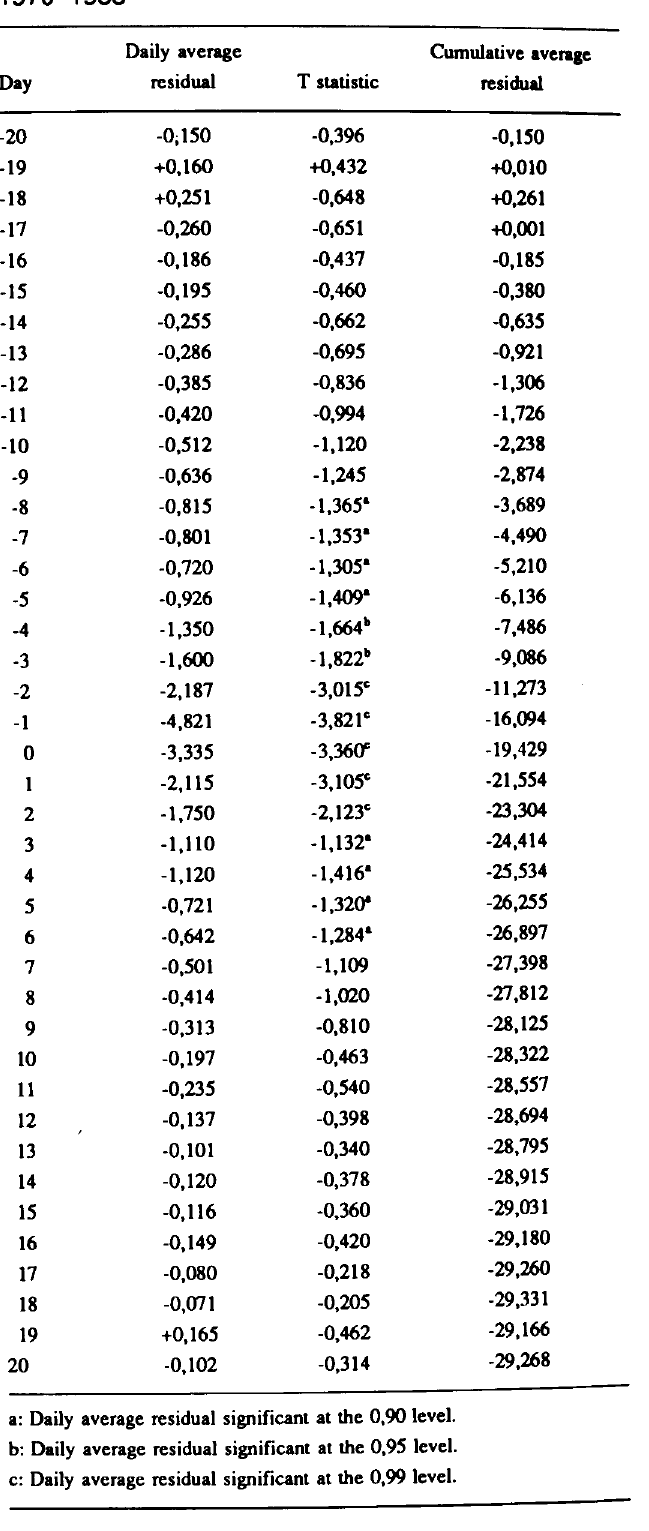
Table 1 Investment return residuals for large dividend decrease sample (minimum decrease of 40%)